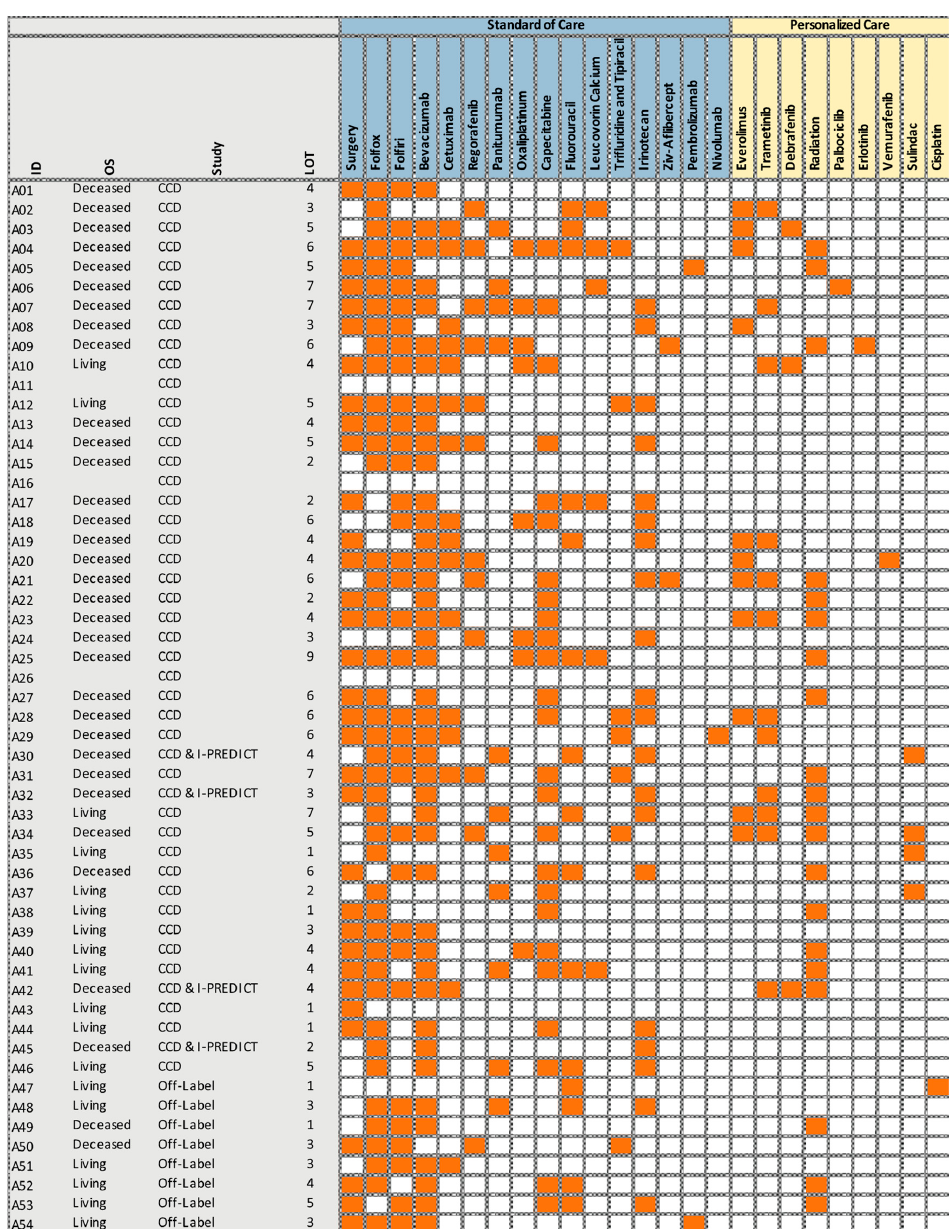
Figure 2. Treatments received by the American patients (A01–A54) in 2008–2017.